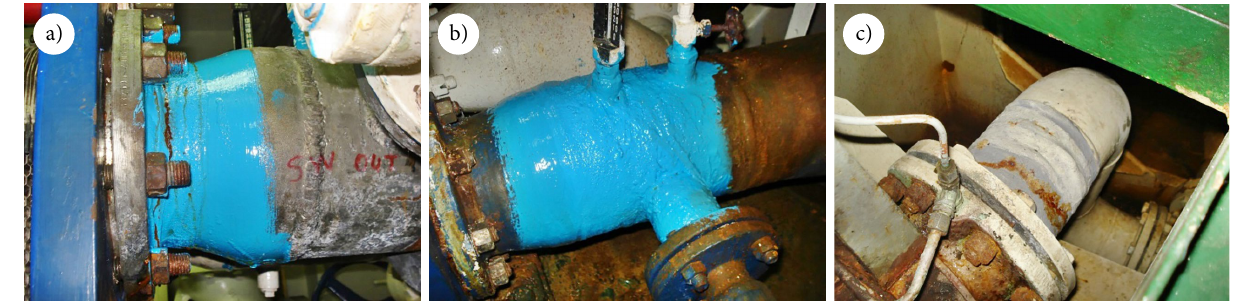
Figure 9. Repair pipe SW (sea water) line for cooling LT (low temperature) contour by comp. materials as Wet Wrap technology of container ship MERWE TRADER (in this case, fiberglass impregnated with compositions based on modified epoxy resins was